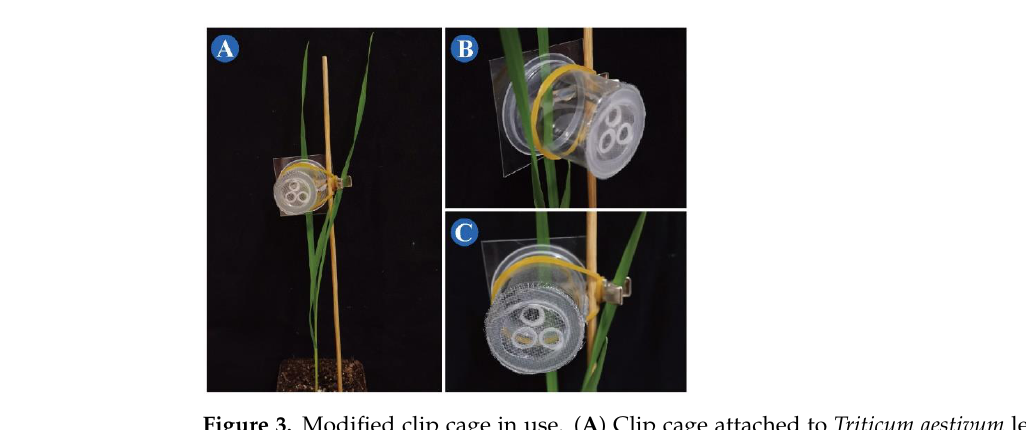
Figure 3. Modified clip cage in use. ( A ) Clip cage attached to Triticum aestivum leaves supported by bamboo skewers and elastic bands. ( B ) Side view of a clip cage in use. ( C ) Front view of a clip cage in use.